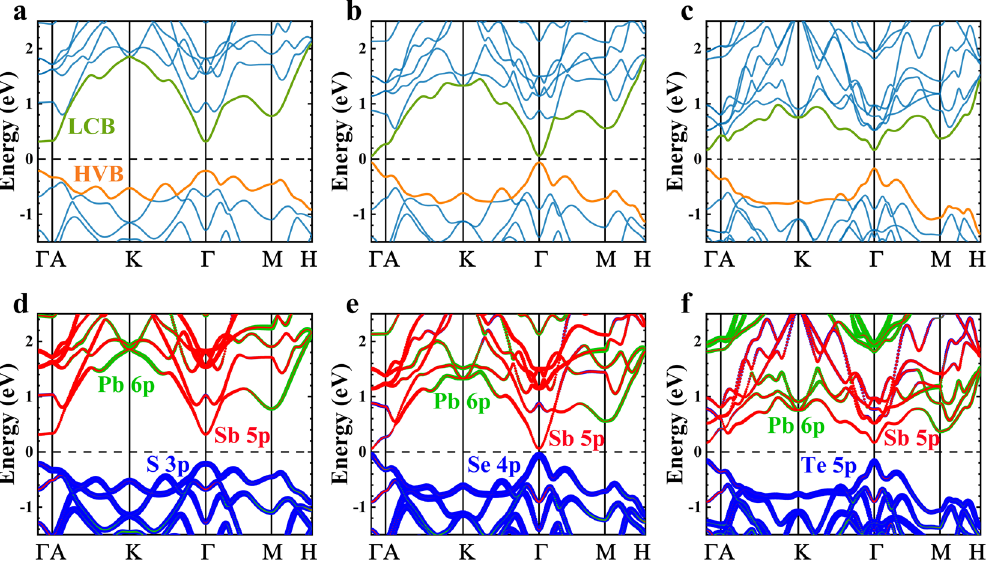
Fig. 4 Electronic band structures. a – c Calculated electronic band structures and d – f projected band structures near the Fermi level (0 eV) for a , d Pb 2 Sb 2 S 5 , b , e Pb 2 Sb 2 Se 5 and c , f Pb 2 Sb 2 Te 5 . The orange and green lines in ( a − c ) represent the highest valence band (HVB) and the lowest conduction band (LCB), respectively. The blue, red, and green dots in ( d − f ) indicate the contribution from VI p, Sb 5p, and Pb 6p valence electrons,